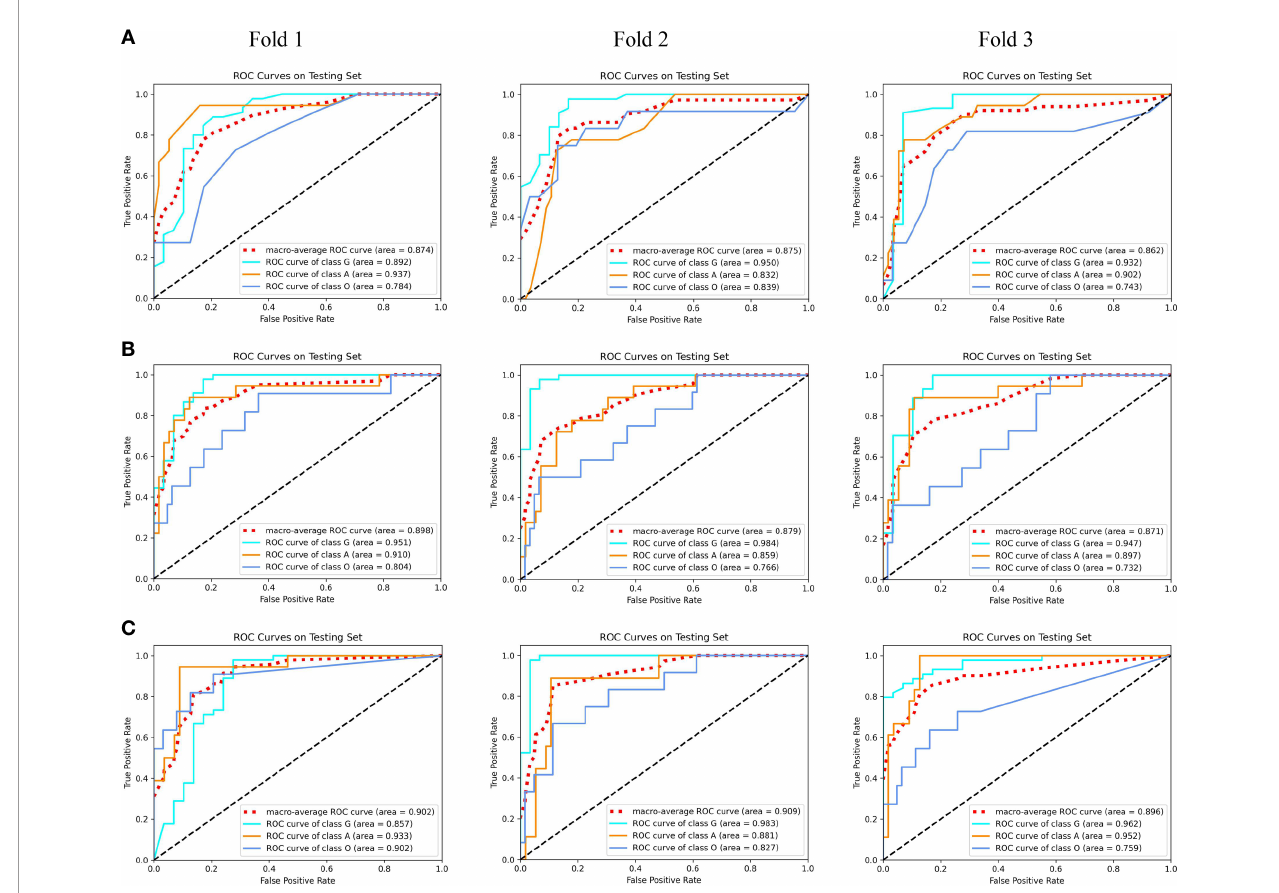
FIGURE 4 | The receiver operating characteristic (ROC) curves of multimodal prediction models on three validation folds in our study. (A) Radiomics model. (B) Data fusion model. (C) Decision fusion model.